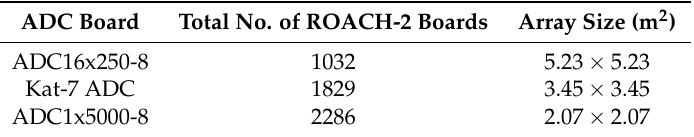
Table 4. Hardware resource consumption, complexity and planar array sizes at different ADC sampling